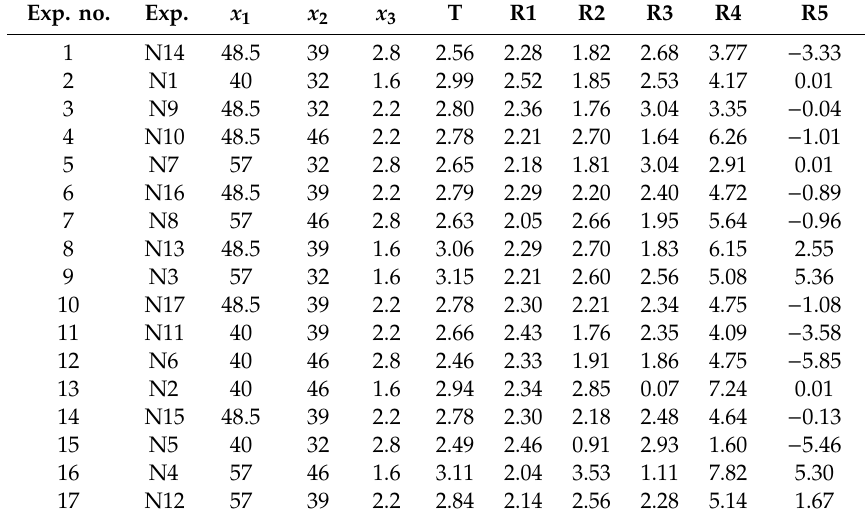
Table 3. Central composite face-centered design and the results of measured responses (CMAs). Exp. no.